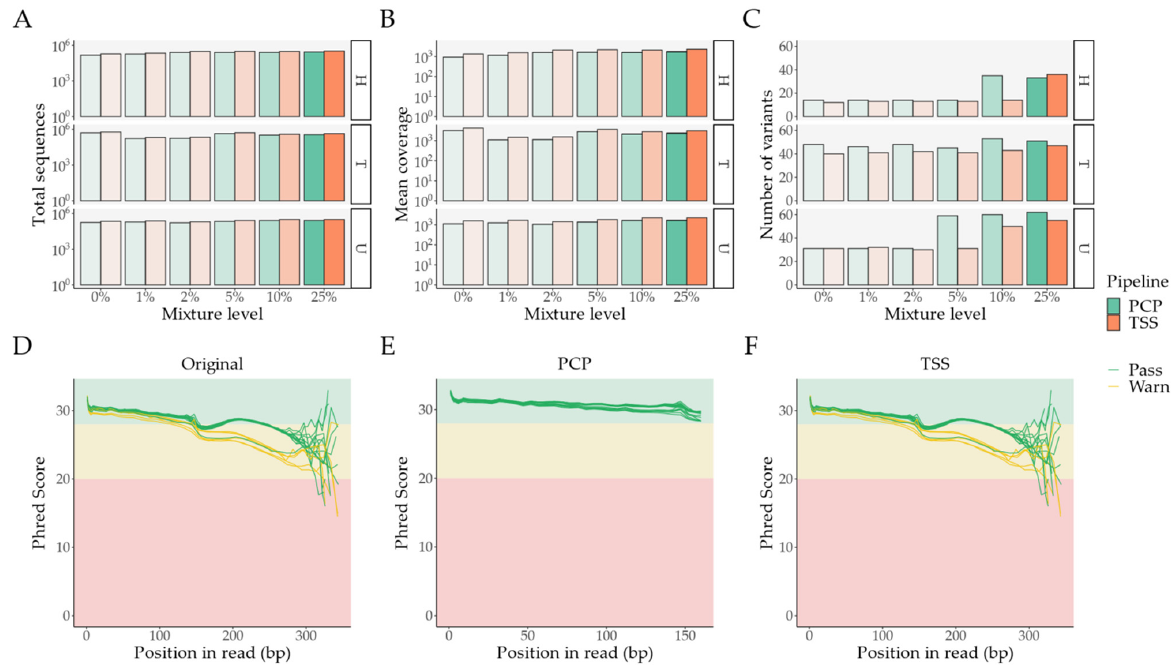
Figure 3. Ion Torrent sequencing: Overall look at differences between PCP and TSS; a 0% mixture level denotes unmixed samples. ( A ) Total number of sequences per pipeline and major sample contributor; ( B ) Mean coverage per pipeline and major sample contributor; ( C ) Number of variants per pipeline and major sample contributor; ( D–F ) MultiQC’s Phred score per base pair in the unprocessed FASTQ files, PCP’s BAM to FASTQ files, and TSS’s BAM to FASTQ files, respectively. Abbreviations: bp—base pair; PCP—PrecisionCallerPipeline; TSS—Ion Torrent Suite™